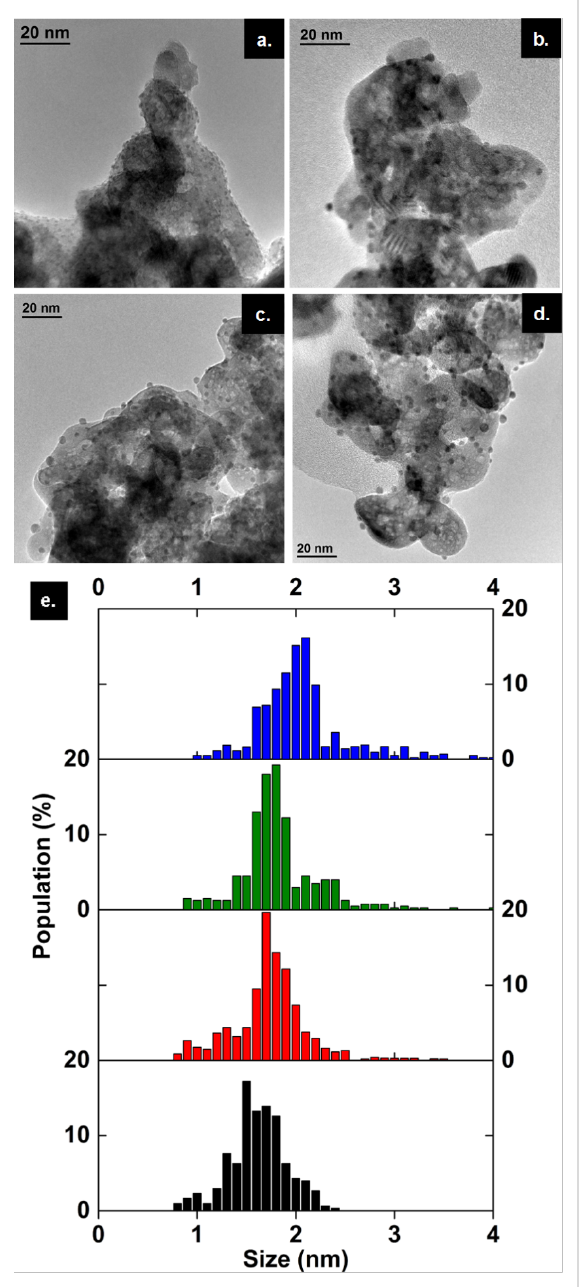
Figure 3: TEM images of Au 25 (SG) 18 @ZrO 2 (Au 0.7 wt %) (a) before calcination, sample (A), (b) calcined at 200 °C for 4 hours under air, sample (A 200 ), (c) calcined at 300 °C for 4 hours under air, sample (A 300 ), and (d) calcined at 400 °C for 12 hours under air, sample (A 400 ), and (e) the size distribution of the composites – (A) in black, (A 200 ) in red, (A 300 ) in green and (A 400 ) in blue.